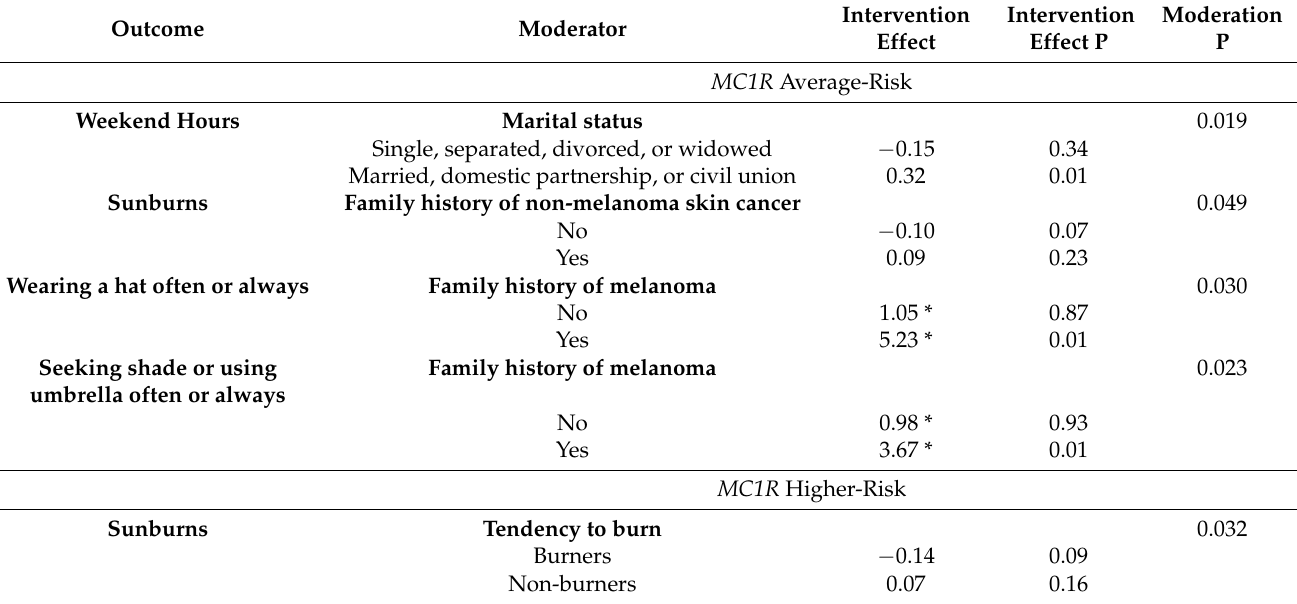
Table 4. Stratum-specific intervention effects for statistically significant